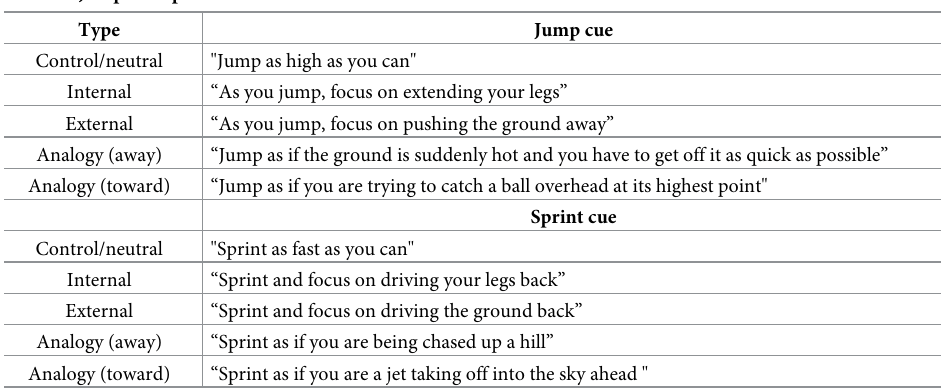
Table 2. Jump and sprint